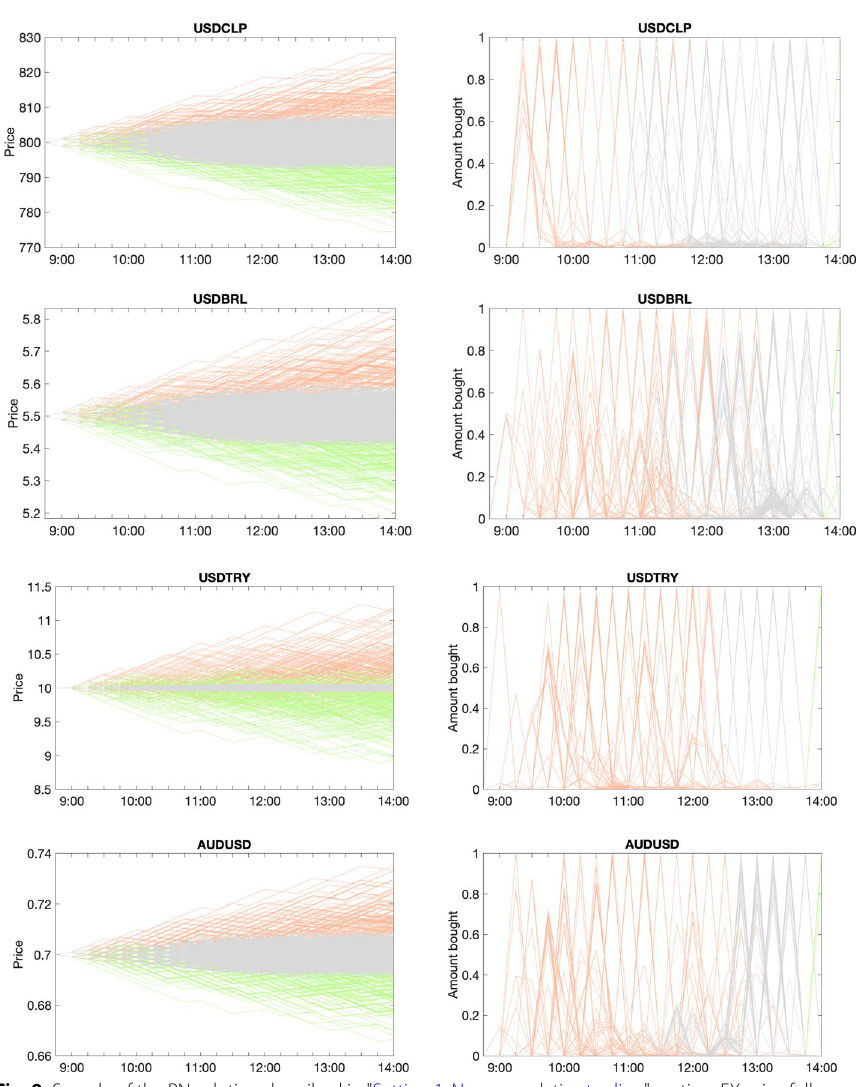
Fig. 9 Sample of the RN solution described in "Setting 1: Non‑speculative trading" section. FX price follows the dynamics in (15). Scenarios in grey follow the Vasicek model during the entire day. Scenarios in green and red have a shock during the day, which changes the dynamics to a GBM model with negative(green) or positive(red)